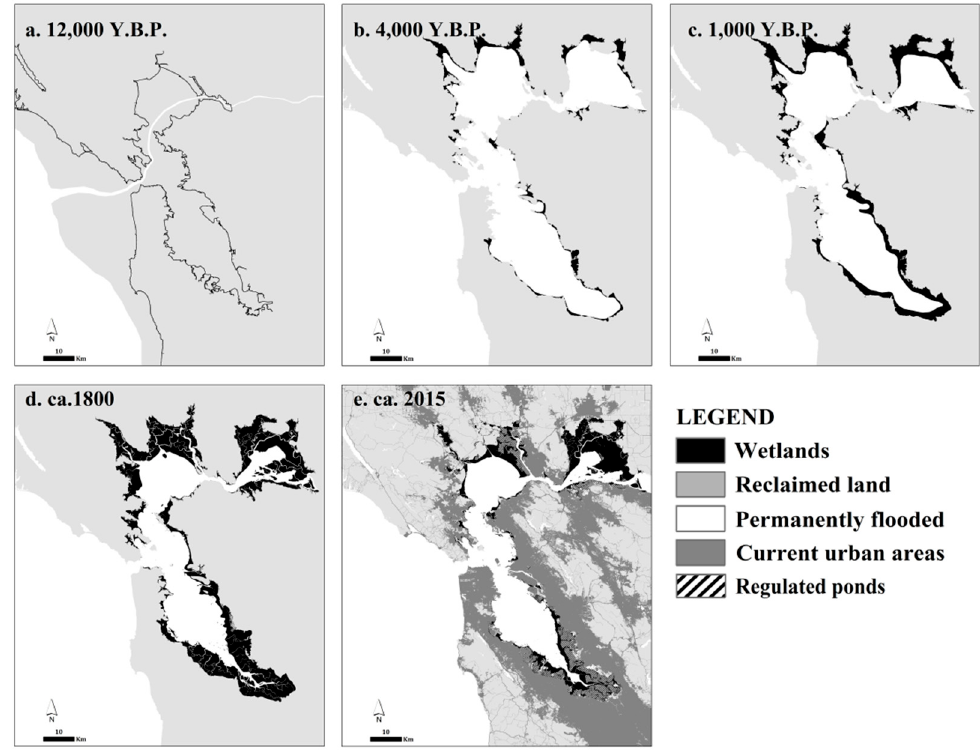
Figure 3. Environmental history of the San Francisco Bay: ( a ) Around 12,000 Years before Present (Y.B.P.), with sea-level much lower than present, the narrow river channel emptied into the ocean near the Farallones Islands; In the following millennia, the Bay was flooded with rates of SLR of about 2 cm/year. Around 5000–4700 Y.B.P., following a ten-fold drop in the rate of SLR, wetlands were able to establish more permanently on sheltered sections of the estuary and, by ( b ) ~4000 Y.B.P., wetlands occupied sheltered and sediment-rich edges; ( c ) ~1000 Y.B.P., early human activity around the Bay and the Central Valley have influenced sediment input, but the pattern of slow accretion and expansion of wetlands persists; ( d ) ca. 1800, grazing and changes to land cover upstream accelerate sediment deposition and wetlands expand rapidly; ( e ) Current situation. After one century marked by much-accelerated deposition due to hydraulic mining, wetlands expand in the mid-1800s, only to be transformed along their edges into farmland, salt ponds, and urban areas. Especially along the South Bay and on the north edge of San Pablo Bay, vast areas remain diked to this day, but recent restoration efforts are converting most of the former salt ponds into restored wetlands. Just upland from these ponds and remaining marshes, most of the farmland has been developed into commerce, industry, housing and infrastructure, encroaching upon most wetlands.